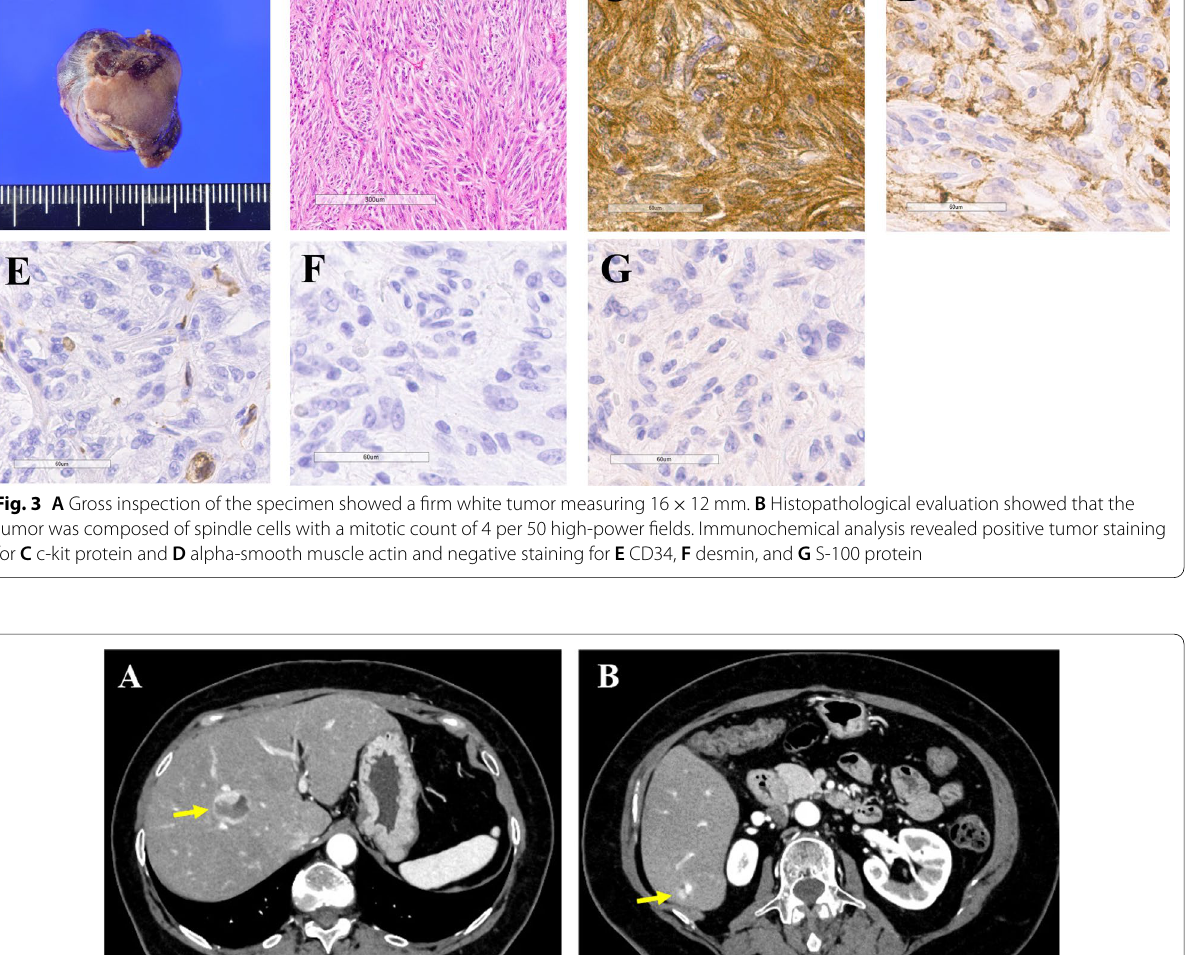
24-mm mass in S8 (arrow) and B a ×